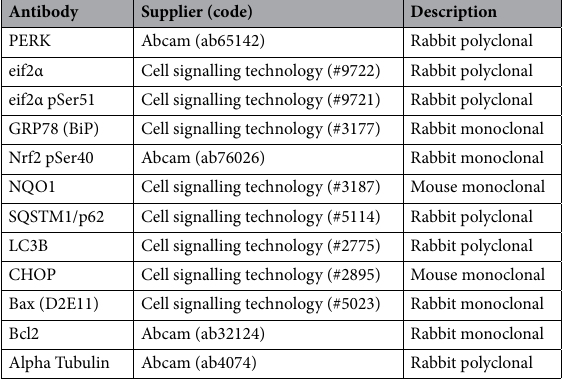
Table 1. Primary antibodies used for western immunoblotting.